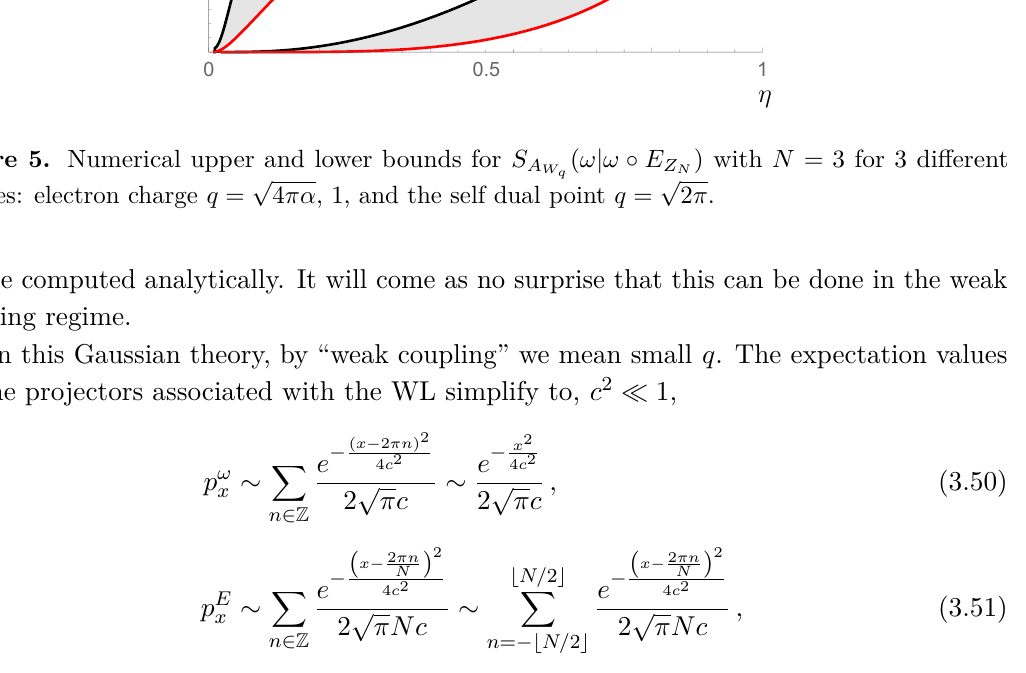
√ 4 πα , 1 , and the self dual point q =